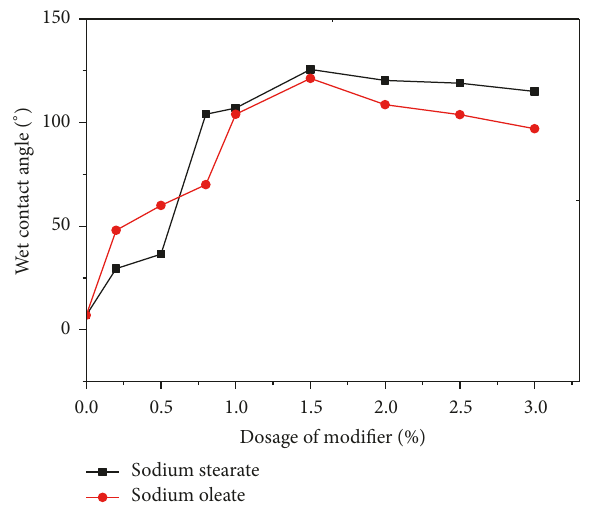
Figure 1: The wetting contact angle of modified TiO 2 in water.